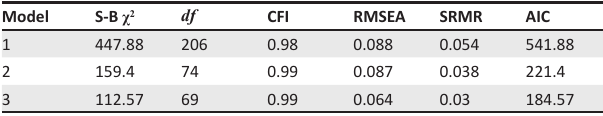
TABLE 1: Goodness-of-fit statistics of the competing measurement models. Model